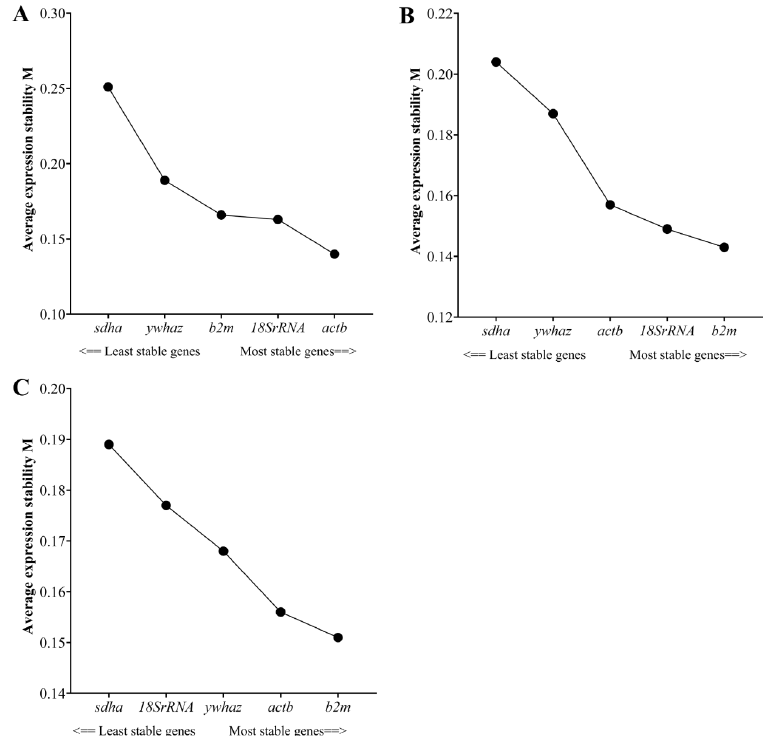
Figure 3. Transcriptional stability value of five candidate reference genes calculated by the geNorm algorithm. The average expression stability value (M) was calculated for actb , 18SrRNA , b2m , ywhaz , and sdha genes on different bovine breeds: Brahman ( A ), Gyr ( B ), and Romosinuano ( C ).